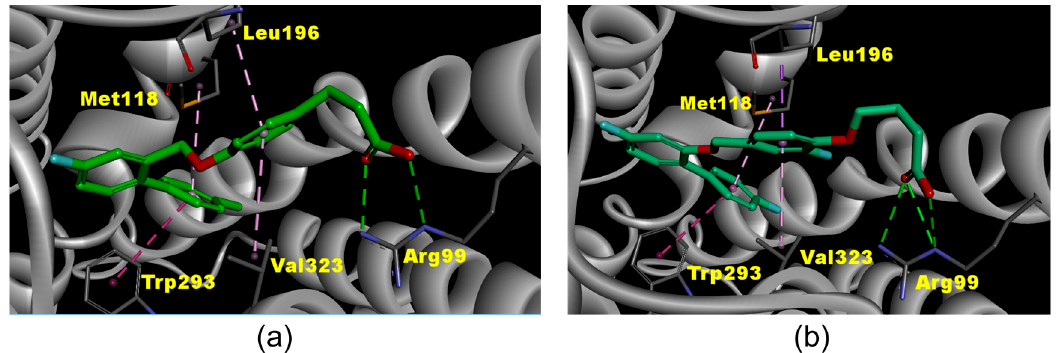
Figure 5. ( a ) Docking of compound 14d inside a homology GPR120 model. ( b ) Docking of TUG-891 inside a homology GPR120 model.